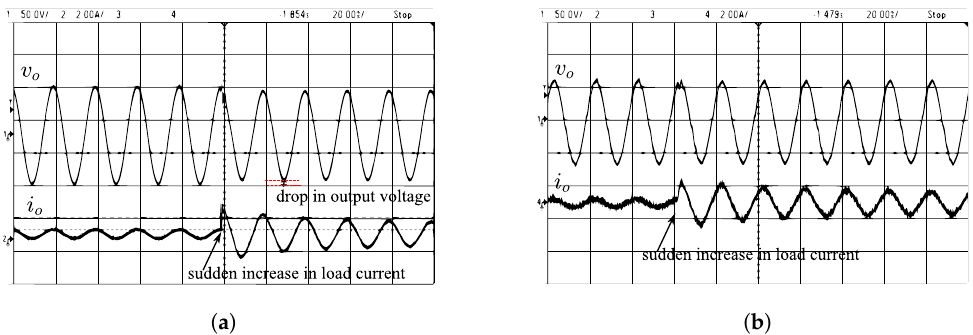
Figure 24. Performance comparison of the proposed system with conventional Sine PWM during transient operating conditions. ( a ) Sine PWM: sudden addition of extra 100 W load, top trace: v o (50 V/div), bottom trace: i o (2 A/div). ( b ) Proposed logic: sudden addition of extra 100 W load, top trace: v o (50 V/div), bottom trace: i o (2 A/div).